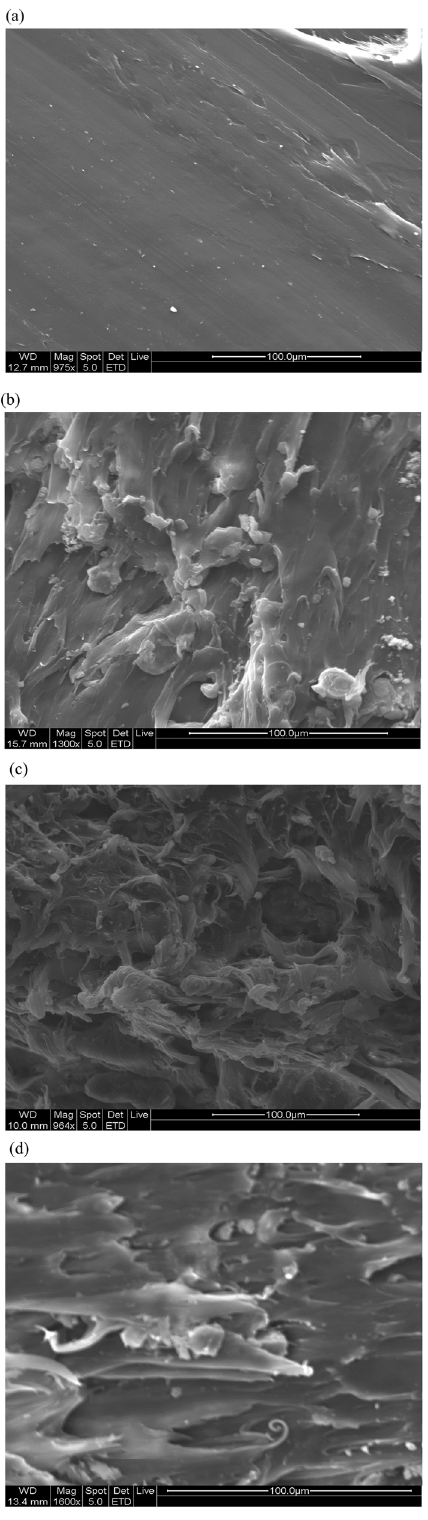
Figure 11: SEM micrographs of the fractured surface: ( a ) pure PP, ( b ) PP/OPF composite without coupling agent, ( c ) PP/OPF composite with 10% P353, ( d ) PP/OPF composite with 10% P613.